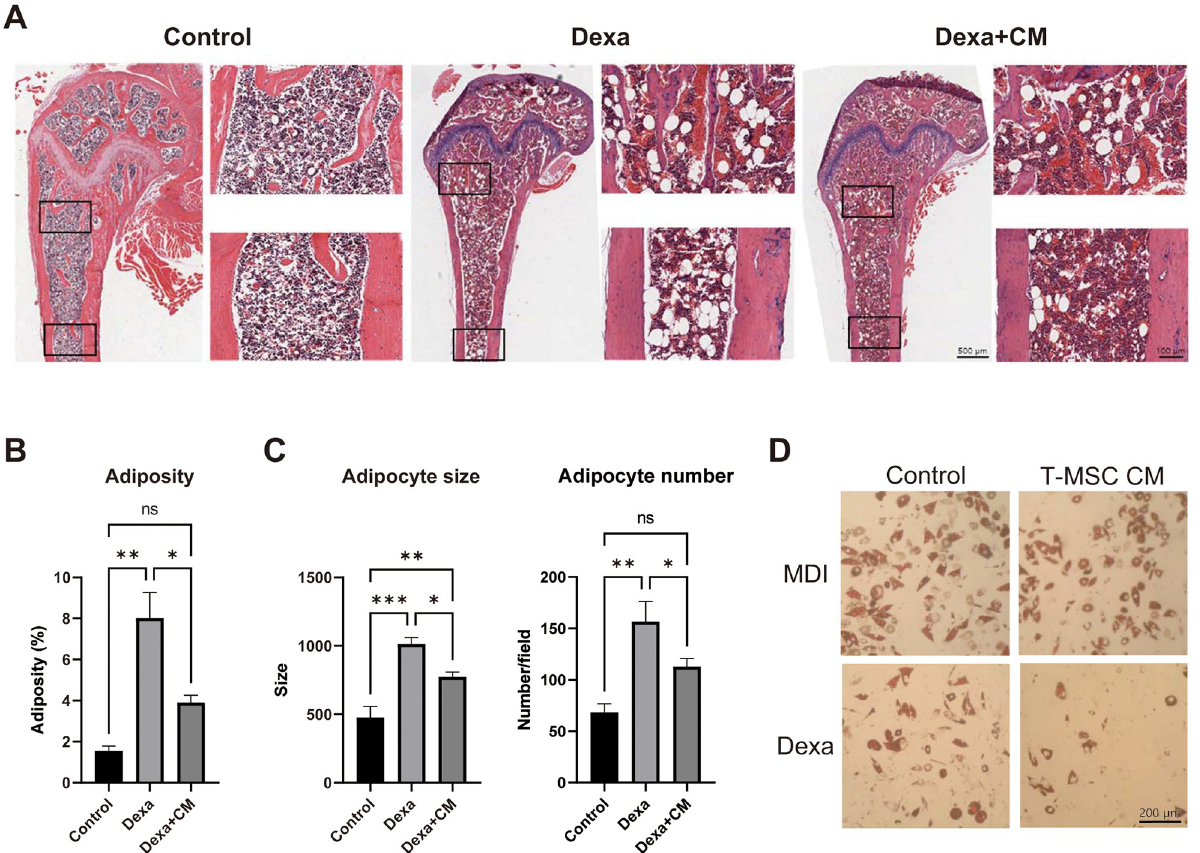
Fig 5. T-MSC CM reduces GC-induced bone marrow adiposity. (A) Representative images of H&E staining from proximal mouse femurs (30 × and 200 × original magnification). (B) Bone marrow adiposity (%) and (C) adipocyte number and size were analyzed using ImageJ software. (D) OP9 mouse bone marrow stromal cells were cultured and treated with adipogenic cocktail or Dexa only, and lipid accumulation was determined by Oil Red O staining. Data are presented as mean ± SEM and were analyzed using one-way ANOVA (n = 5; ns, not significant; � P < 0.05, �� P <